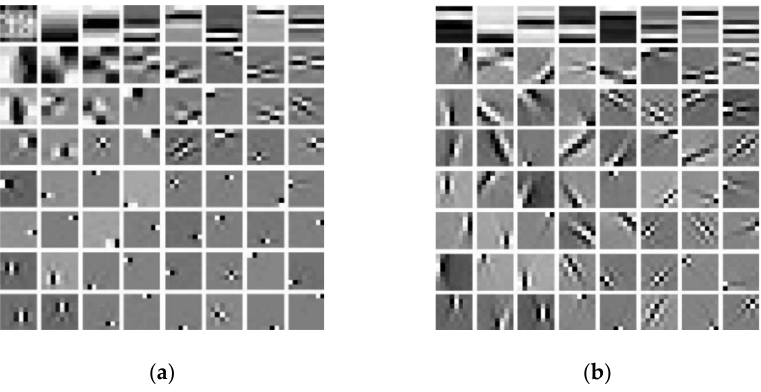
( d ) Figure 6. Image of difference of incident photon number 10 (cid:2873) . ( a ) EP iterative reconstruction; ( b ) DCT image post-processing; ( c ) DL iterative reconstruction algorithm; ( d ) learning sparse transform.